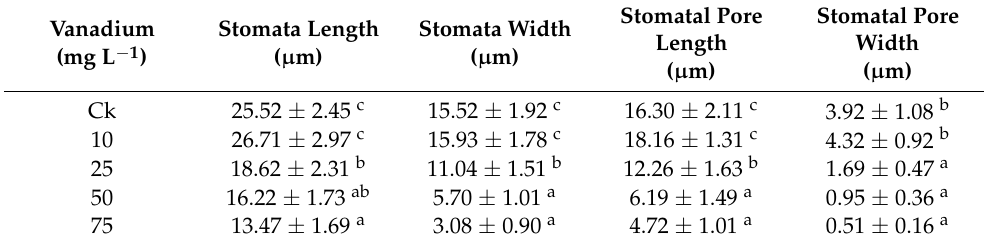
Table 4. Effect of different V treatments on the stomatal traits of sweet potato leaf.